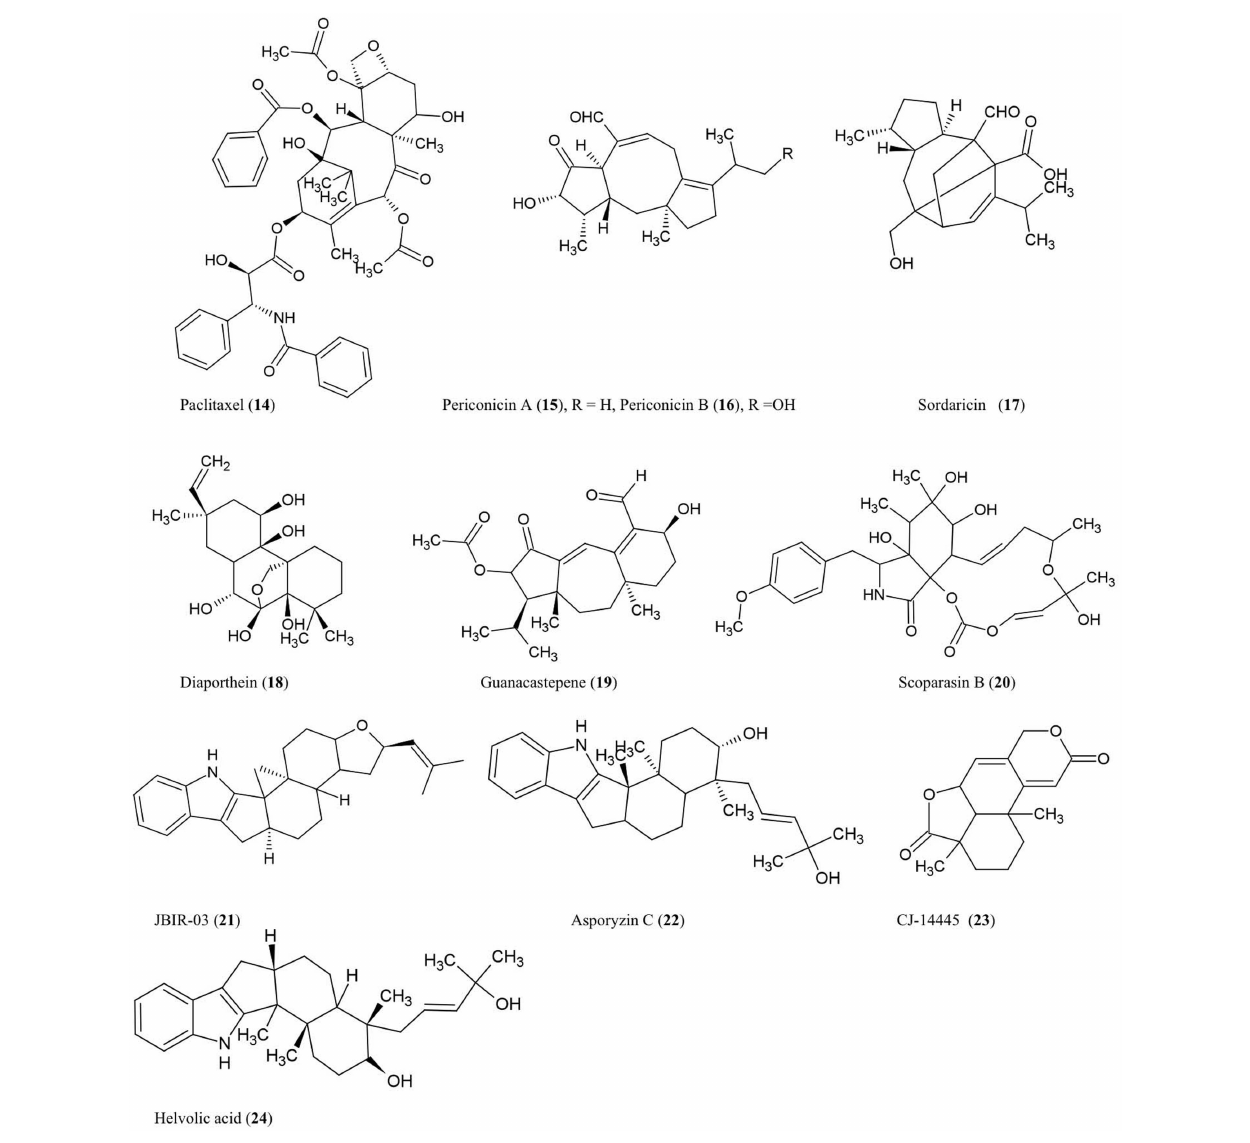
endophyte species inhabiting different plant species (Zhou et